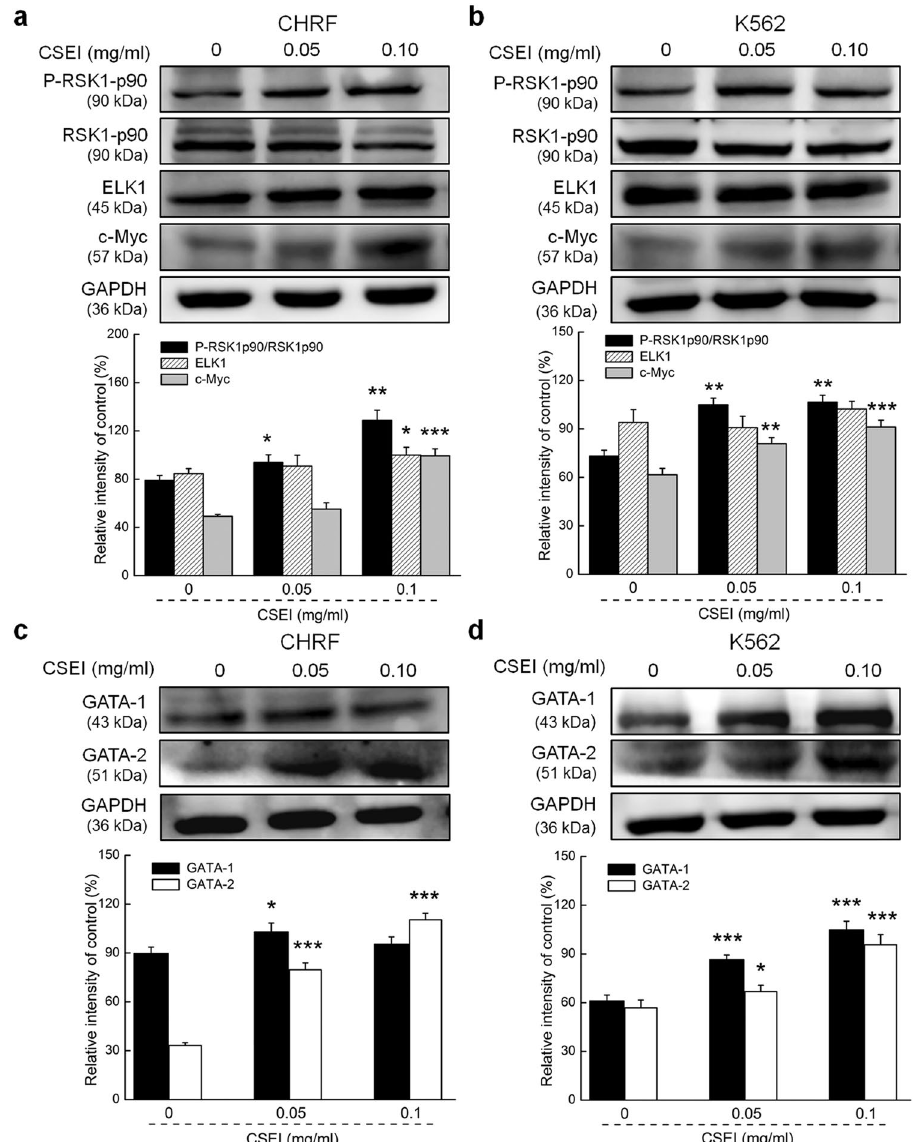
Figure 2. CSEI regulated the expressions of hematopoietic function related proteins in CHRF and K562 cells. After a 24-h CSEI (0, 0.05, 0.1 mg/ml) treatment, the protein expression levels of P-RSK1p90, ELK1 and c-Myc in CHRF cells ( a ) and K562 cells ( b ), full-length blots are presented in Supplementary Fig. S5 a, and the expression levels of GATA-1 and GATA-2 in the terminal mature CHRF cells ( c ) and differentiated K562 cells ( d ) were detected by western blotting, respectively, full-length blots are presented in Supplementary Fig. S5 ( b ). The quantitative data of these protein levels were normalized by their GAPDH expressions and expressed as a percentage of the corresponding relative intensity of control. The data are shown as the means ± S.E.M. (n = 6). * P < 0.05, ** P < 0.01 and *** P < 0.001 versus 0 mg/ml CSEI-treated